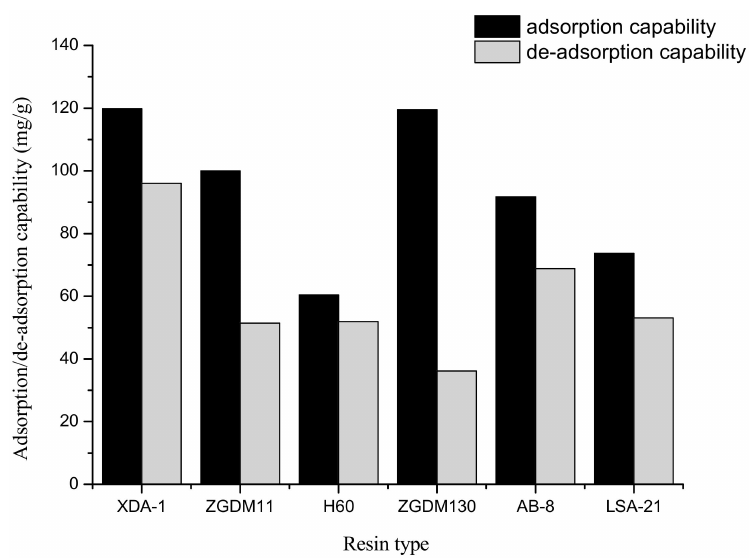
Figure 1. Adsorption and de-adsorption capacity of the six kinds of macroporous resins for the amygdalin.